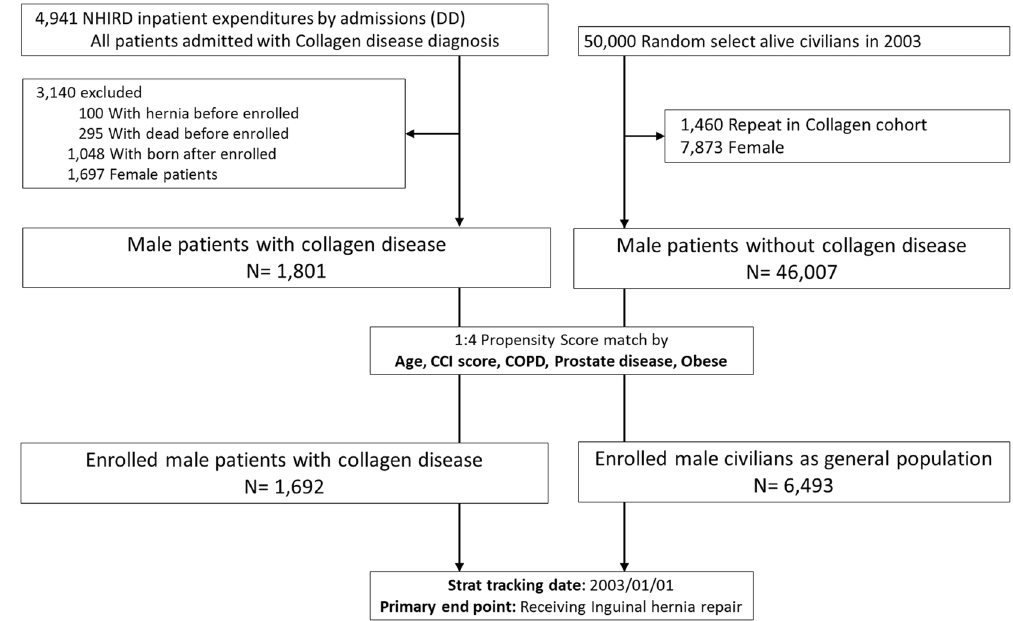
Figure 1. Flow chart showing the inclusion and exclusion criteria of this study.